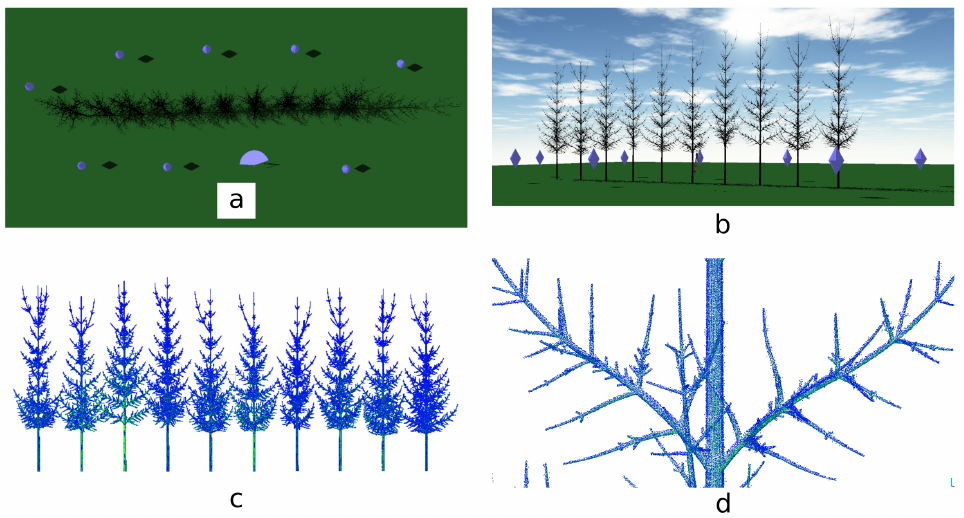
Figure 6. Scenes, sampling plan, and simulated scans for a row of ten 13-year-old trees. The scene of the row, i.e., the mesh created from the mtg files, from above ( a ) and from the front ( b ). In ( a , b ), the TLS positions are represented by the purple diamonds except for one scan position for which the tripod and TLS device as well as its lateral viewing angle are shown. The resulting point clouds for the entire row ( c ) and the details for one tree ( d ) are shown after applying the statistical outliers